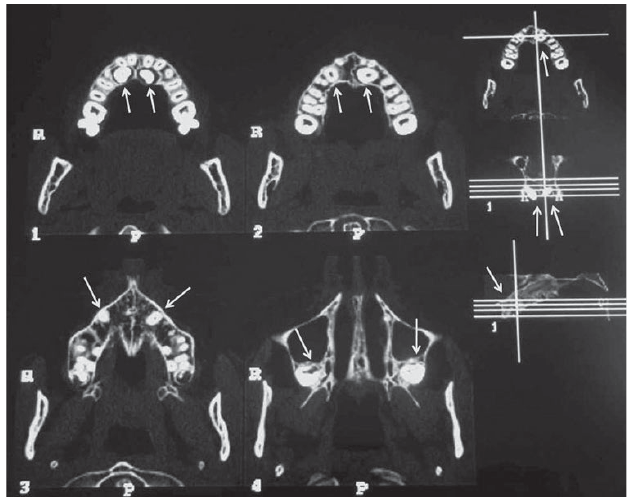
Fig. 7: Maxillary computed tomography image on transversal slice.